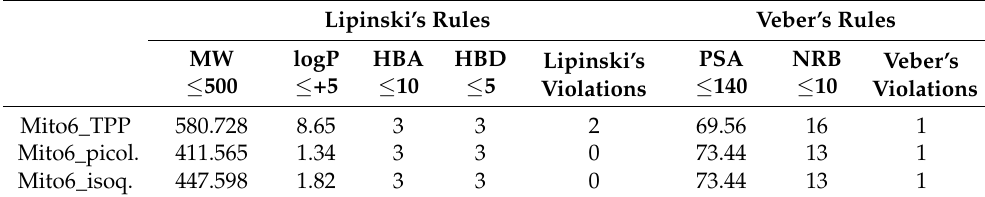
Figure 8. Intracellular reactive oxygen species (ROS) levels in Ishikawa ( a ), Hec50co ( b ), COV434 ( c ), and HFF-1 ( d ) cells in the 2 h immediately after the addition of 10 µ M of Mito6_TPP, Mito6_picol., or Mito6_isoq. Untreated cells containing only the respective cell medium and 2% FBS were used as control and are represented as a dotted line at 100%. H 2 O 2 (200 µ M) was used as the positive control (PC). Results are compared to the control and expressed as mean ± SEM of at least three independent experiments performed in triplicate. Significant differences between treated and untreated cells are described as * ( p < 0.05), ** ( p < 0.01) and *** ( p < 0.001), and **** ( p < 0.0001). Table 2. Theoretical chemical properties of the compounds and their compliance to Lipinski’s and Veber’s rules for oral bioavailability. The values were calculated using MarvinSketch 20.9 with the Calculator